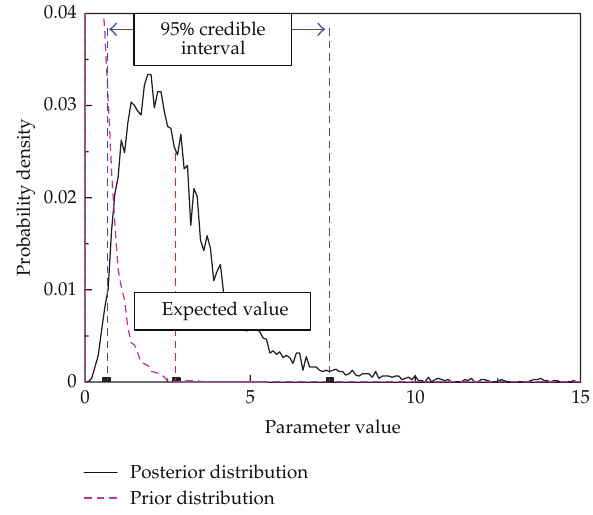
Figure 7: Probability distribution of parameter φ 73